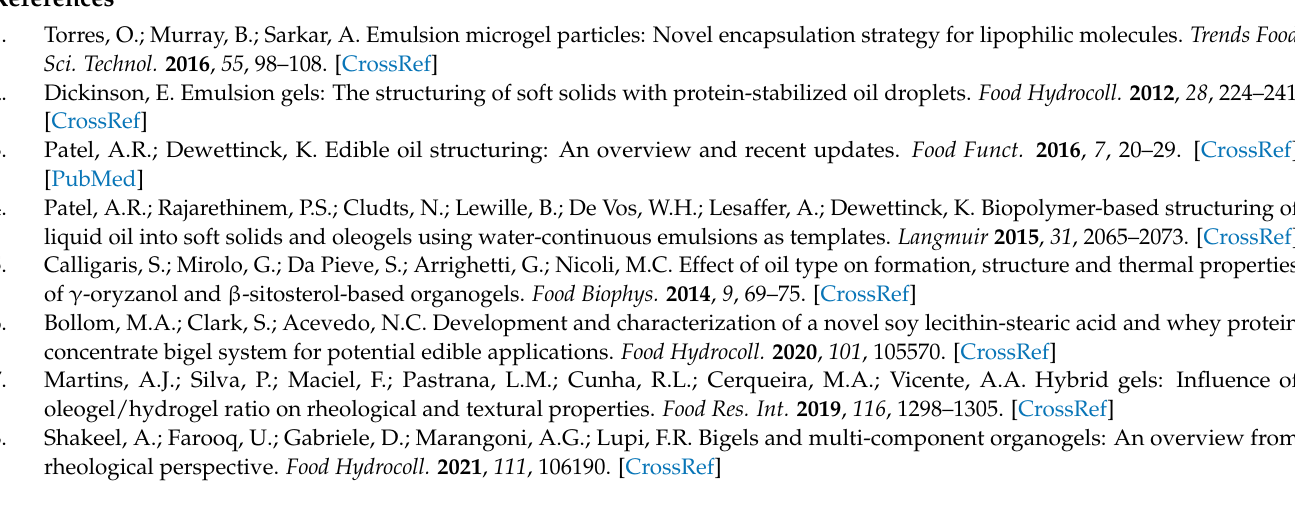
Figure S3: Stress amplitude for MG oleogels with different MG concentrations; Figure S4: XRD diffractograms of dual-structured gel emulsions; Figure S5: Large-deformation compression of dual-structured gel